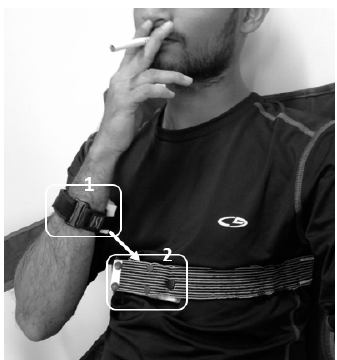
Figure 4. The concept of proximity sensor: Closeness of hand to mouth, i.e., the closeness of module 1 to module 2. Table 5. Comparison of two versions of Radio Frequency (RF) Proximity sensors employed in smoking research.